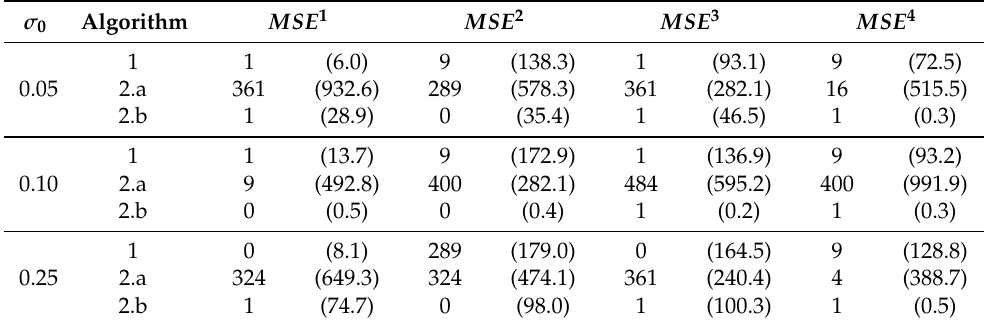
Table 1. Mean values of MSE j , j = 1,...,4 (standard deviation in brackets) for different values of σ 0 . σ